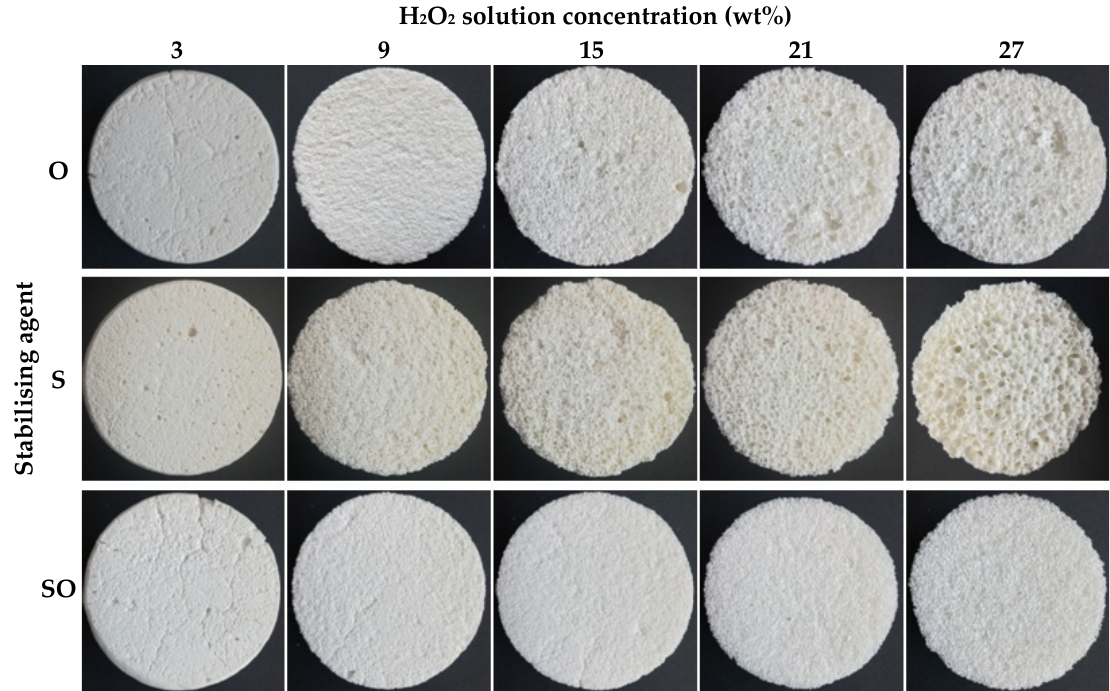
Figure 2. Effect of the dilution of the H 2 O 2 solution and type of stabiliser on the pore